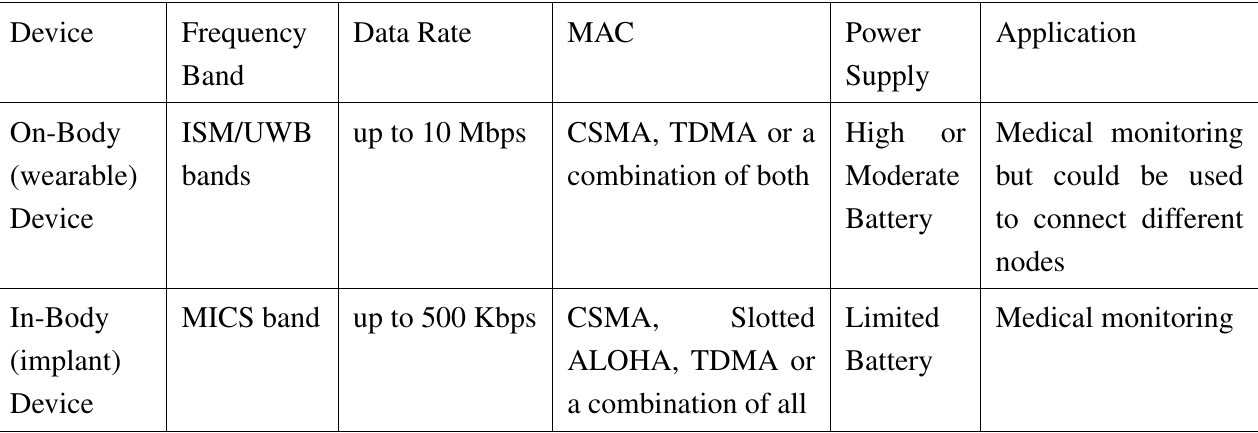
Table 1. In-body and on-body nodes